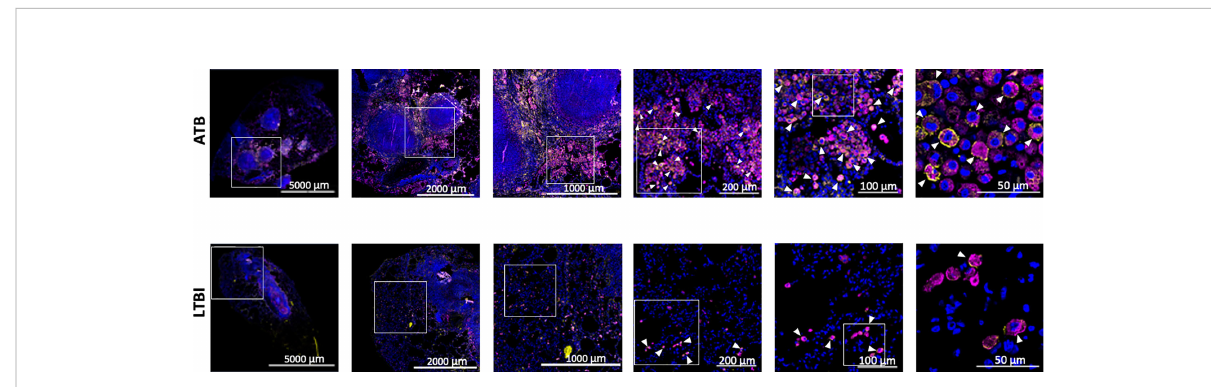
FIGURE 5 Confocal microscopy based validation of MX1 expression. Multilabel immuno fl uorescence confocal images validating in vivo expression of MX1 (yellow) in CD68 (magenta) expressing macrophage cells in a representative FFPE section from lungs of ATB and LTBI macaques. Arrow heads show macrophages (CD68+) expressing MX1. The images shown here are from the advance stage lesions (granulomas). Majority of the macrophages in ATB lung are seen to express MX1, whereas in LTBI lung, the macrophages expressing MX1 are fewer in